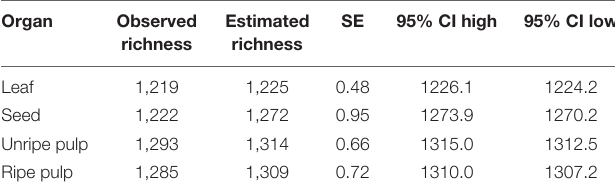
TABLE 3 | Rarefaction results showing total estimated richness for each organ across all 12 Piper species